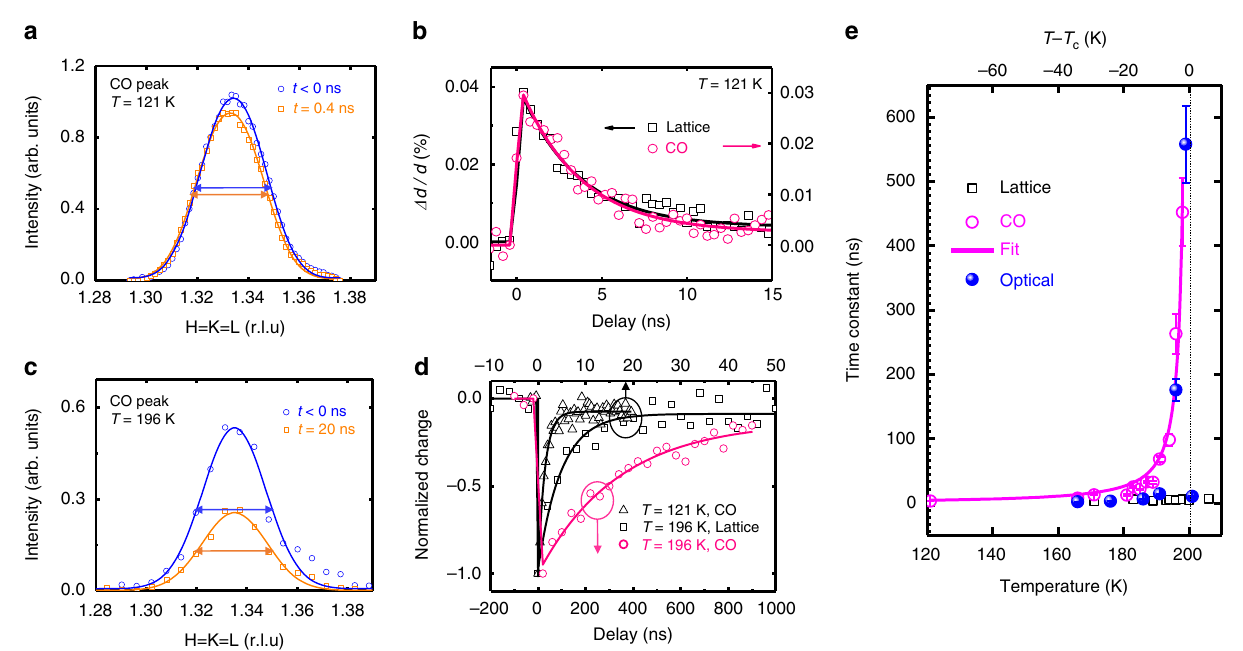
Fig. 3 Time-resolved X-ray diffraction measurements. a Radial scans of CO peak measured at 121 K at various delays. The solid lines are Gaussian fi ts. The double-arrow lines with identical length show that the full width half maxima of the peaks before and after excitation are equal within the resolution. The HKL are indexed with respect to the LSFO ground-state lattice at speci fi ed temperatures. b Out-of-plane strain of lattice (black square) and CO superlattice (pink circle) as a function of the delay, with the fi t result shown as solid lines. c Radial scans of CO peak measured at 196 K at various delays. d CO peak intensity as a function of delay is measured at T = 121 K (black triangles) and 196 K (pink circles). Lattice strain as a function of time measured at T = 196 K (black squares). e Recovery time constants of CO intensity τ CO and lattice peak shift τ lattice measured as a function of sample temperatures at an absorbed pump laser fl uence of 2.9 mJ cm − 2 . The error bars show the fi tting error. The solid line shows the fi t of X-ray data based on the power law (1 − T/T c ) − Δ . The dotted line indicates the transition temperature. The blue solid balls show the recovery time constant of optical re fl ectivity, also shown in Fig.